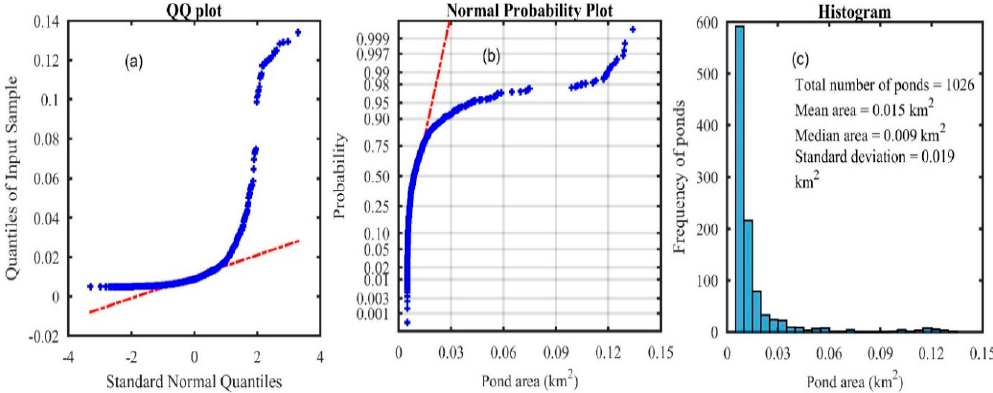
Figure 5. The distribution of pond areas (1989–2017) in the Everest region with (a) normal Q-Q plot of pond area, (b) normal probability plot of pond area, and (c) frequency distribution of ponds.